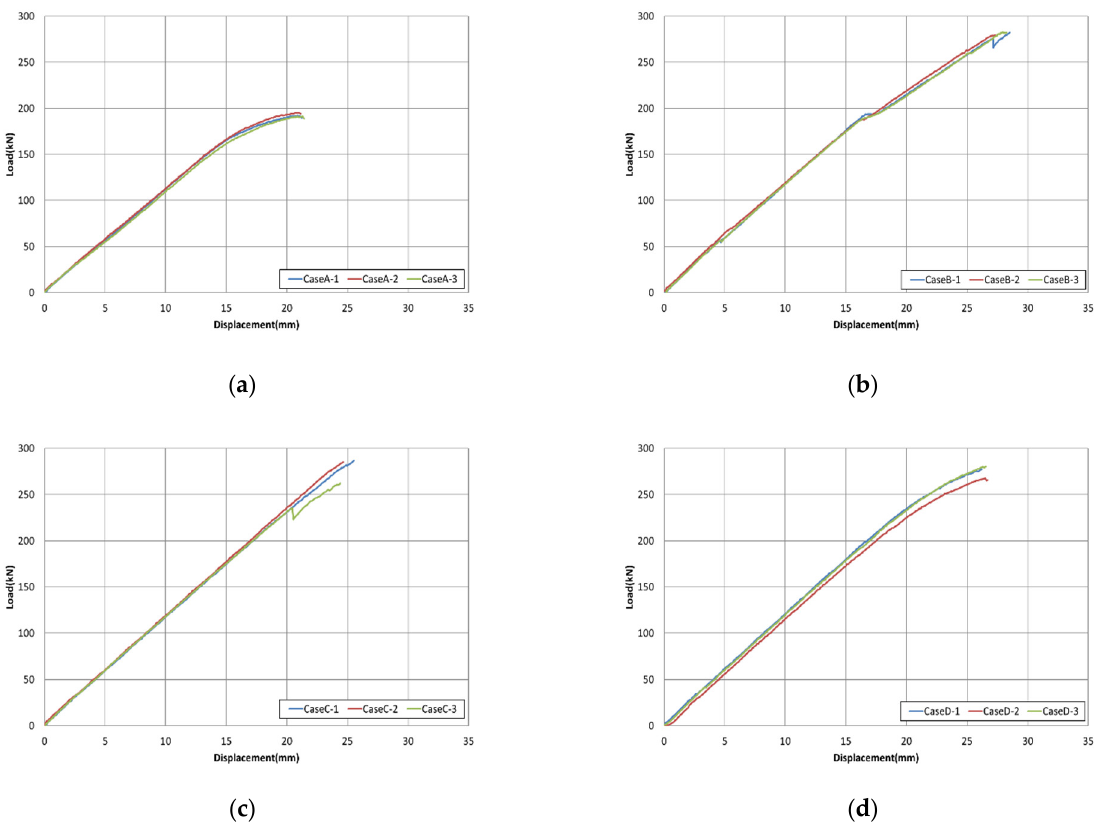
Figure 12. Load–displacement curves with the round mold steel pipe for bond performance improvements: Cases ( a ) A, ( b ) B, ( c ) C, and ( d ) D.